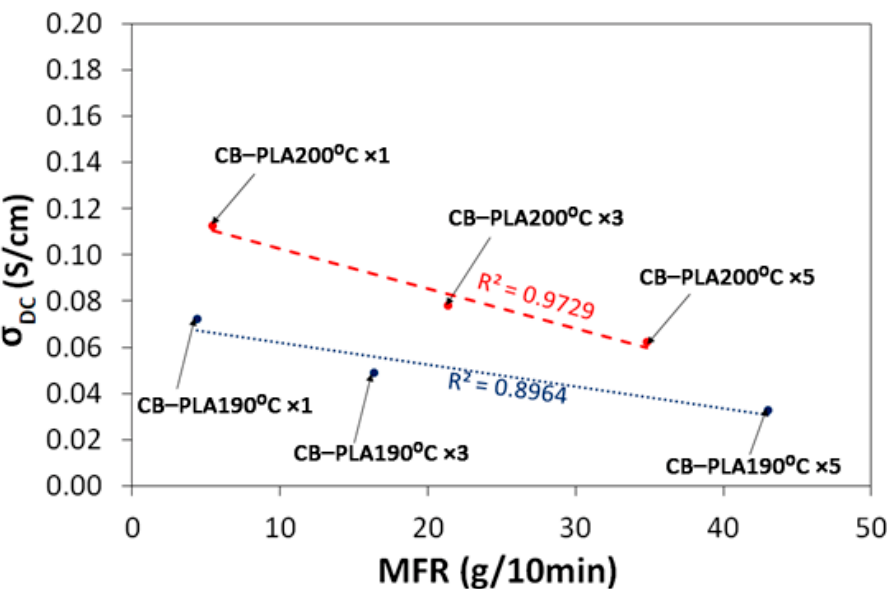
Figure 6. Changes in electrical conductivity as a function of MFR changes for multiple reprocessing cycles of CB–PLA at 190 °C and 200 °C.